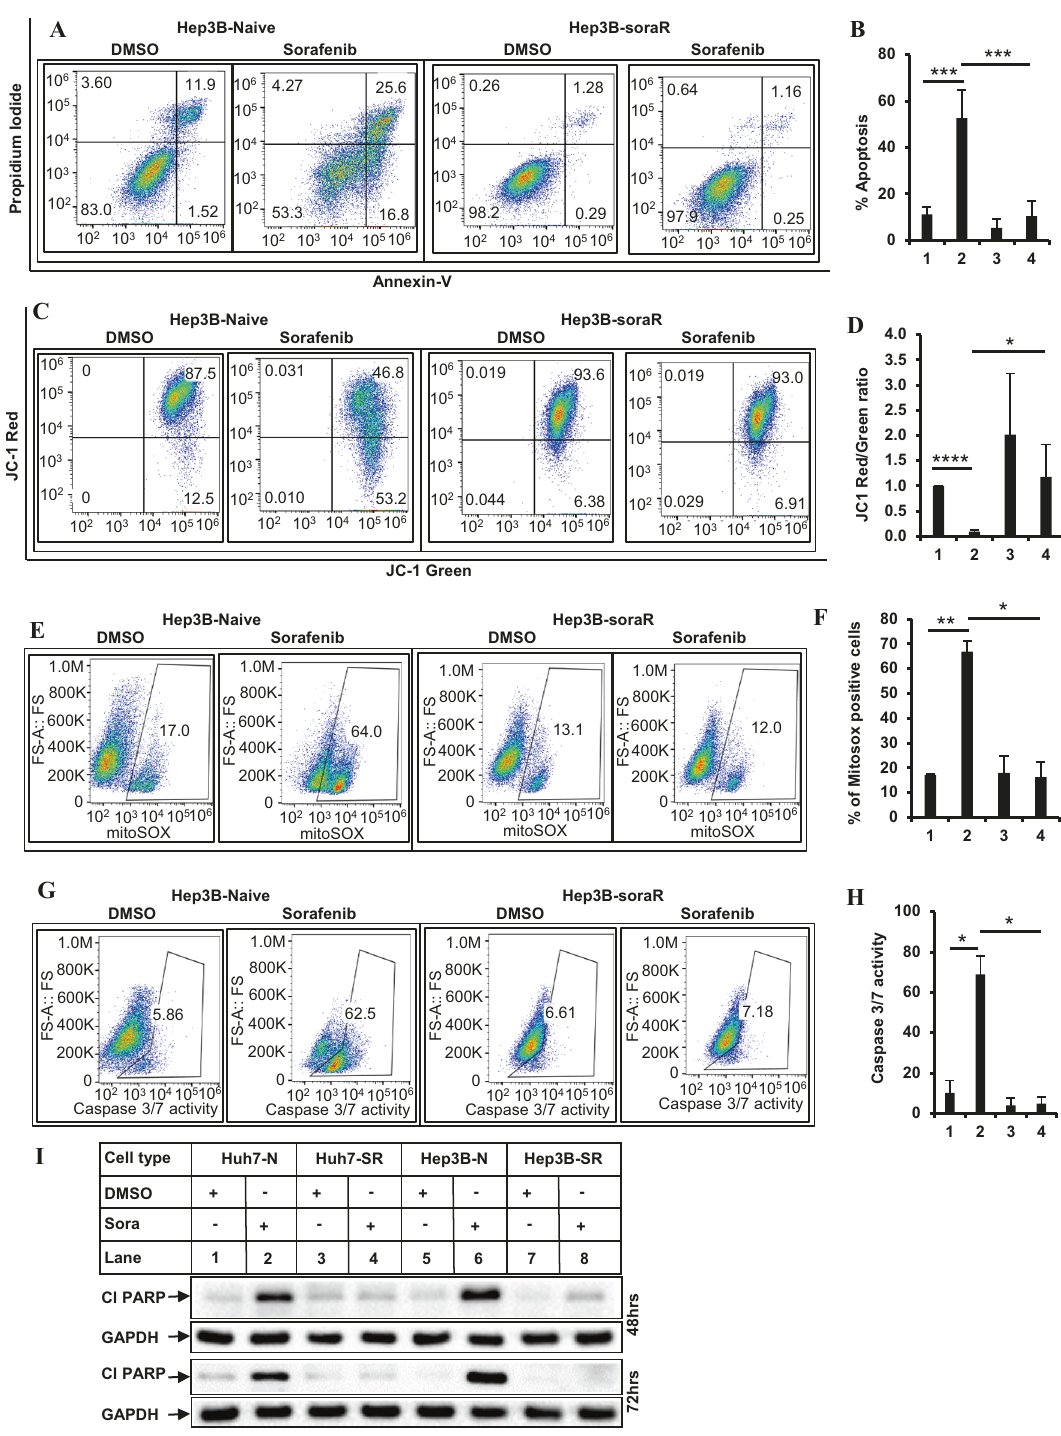
Fig. 2 soraR cells are resistant to sorafenib-induced apoptosis and mitochondrial damage. A Representative images of fl ow-cytometric detection of apoptosis in naive and soraR Hep3B cells treated with DMSO or sorafenib (6 µM) for 72 h. Cells were harvested and analyzed for apoptosis using FITC Annexin V Apoptosis Detection Kit. The bar graphs in B represent the % of total apoptosis under different treatment conditions. C Hep3B-naive and soraR cells treated as in A were analyzed to detect changes in mitochondrial membrane potential after staining with JC-1 dye. The bar graphs in D represent the ratio of JC-1 Red/JC-1 green. E Hep3B-naive and soraR cells treated with DMSO or sorafenib (6 µM) for 24 h were incubated with 5 µM MitoSOX, followed by fl ow cytometry to detect mitochondrial ROS. The bar graphs on the right ( F ) represent the % of mitosox-positive cells. G Hep3B-naive and soraR cells treated as in A were incubated with CellEvent Caspase-3/7 green detection reagent and subjected to fl ow cytometry to detect caspase 3/7 activity. The bar graphs on the right ( H ) represent changes in caspase 3/7 activity under different treatment conditions. The data (in B , D , F , H ) represent the mean ± S.D. of two to four independent experiments. Hep3B-N cells were treated with DMSO (lane 1), or sorafenib (lane 2); Hep3B-SR cells were treated with DMSO (lane 3), or sorafenib (lane 4). Signi fi cant differences were determined by t test and indicated as: * p ≤ 0.05; ** p ≤ 0.01; *** p ≤ 0.001; **** p ≤ 0.0001. I Naive and soraR HCC cells were treated with DMSO or sorafenib (6 µM) for 48 and 72 h and analyzed by western blots with antibodies against PARP or GAPDH. PARP poly (ADP-ribose) polymerase, Cl PARP cleaved